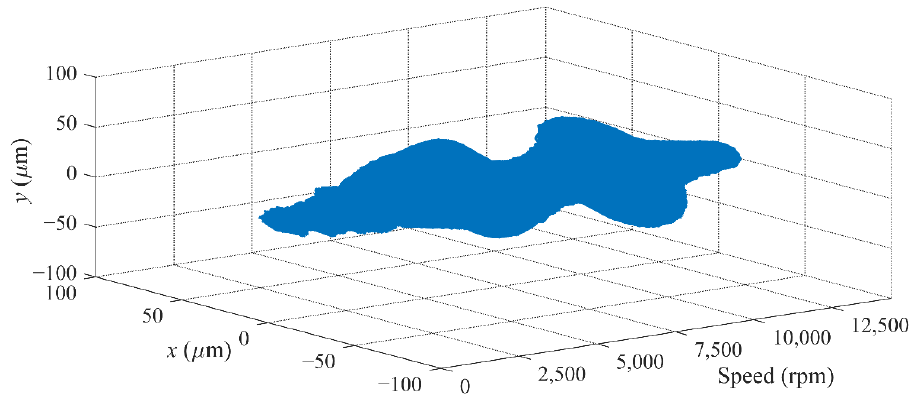
Figure 17. Rotor trajectory during running up with the μ -controller.